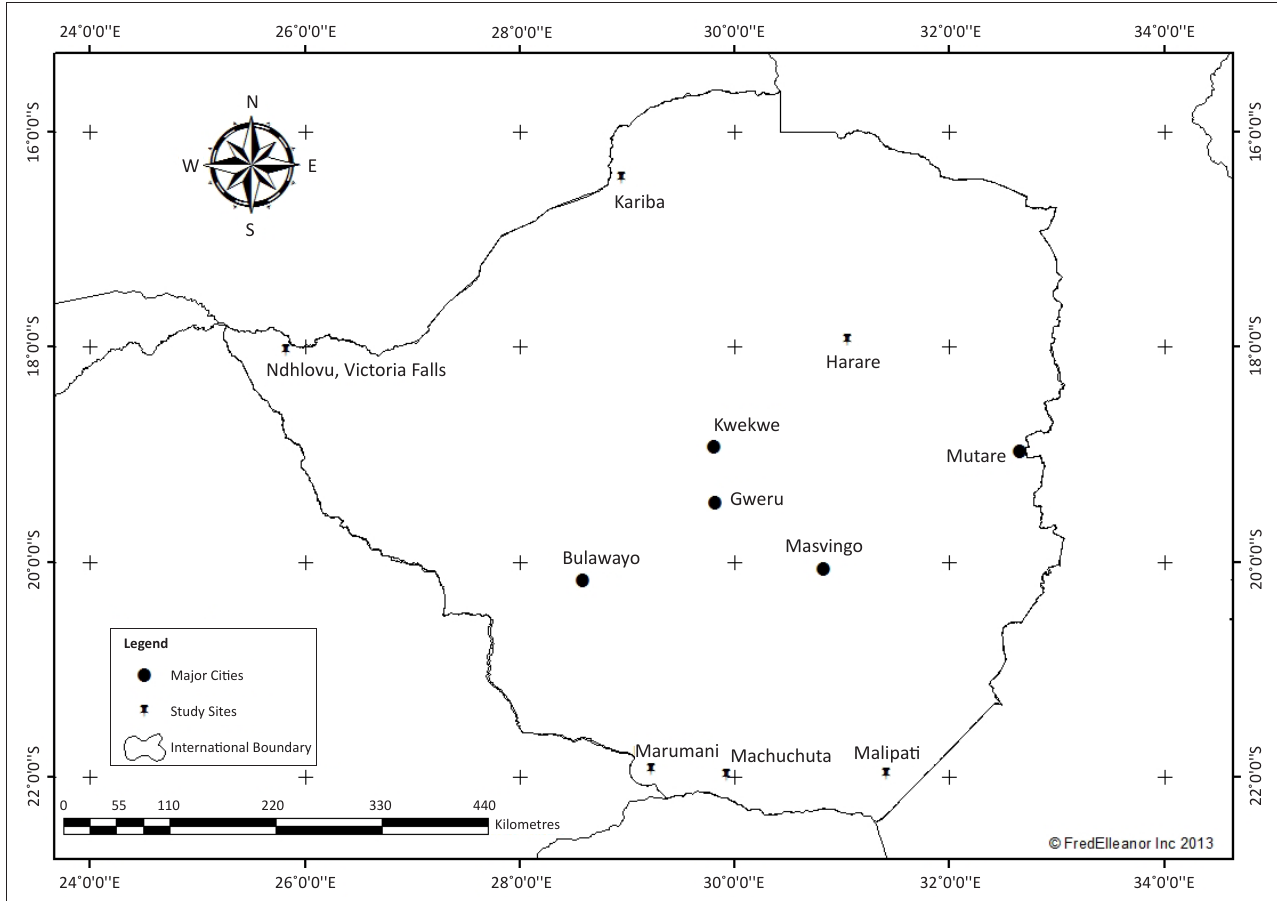
FIGURE 1: Map of Zimbabwe showing the sites where samples were